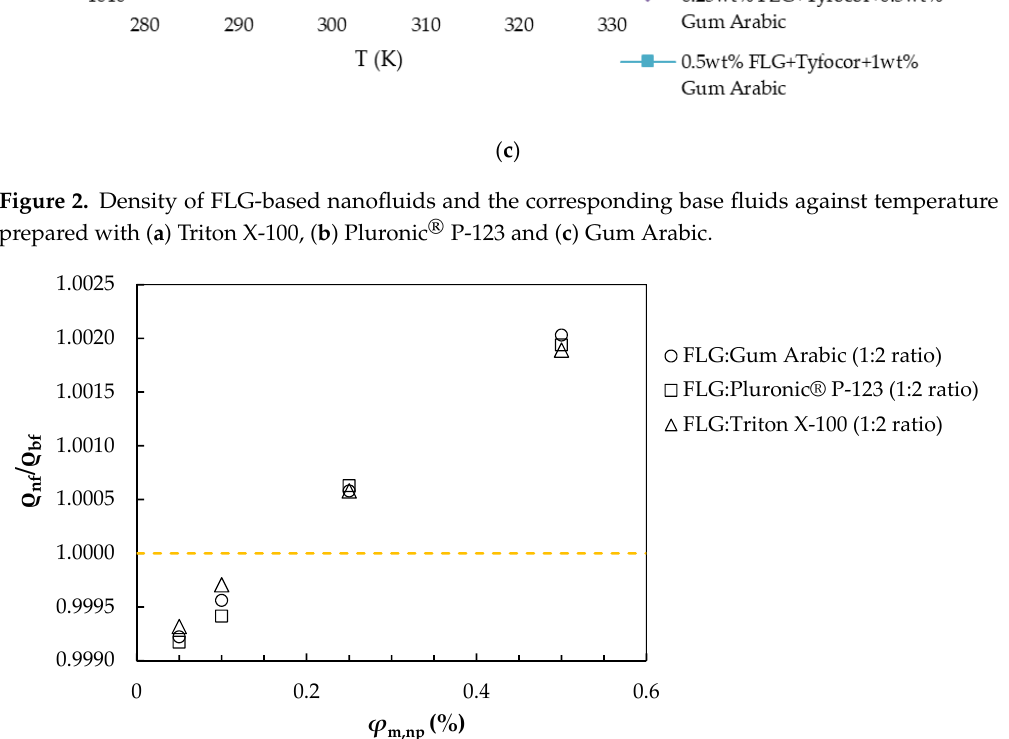
Figure 3. Relative density of nanofluids, which is defined as the ratio of the nanofluids density to the corresponding base fluids density (Tyfocor ® LS–surfactant mixtures), as a function of FLG mass concentration at 303.15 K.